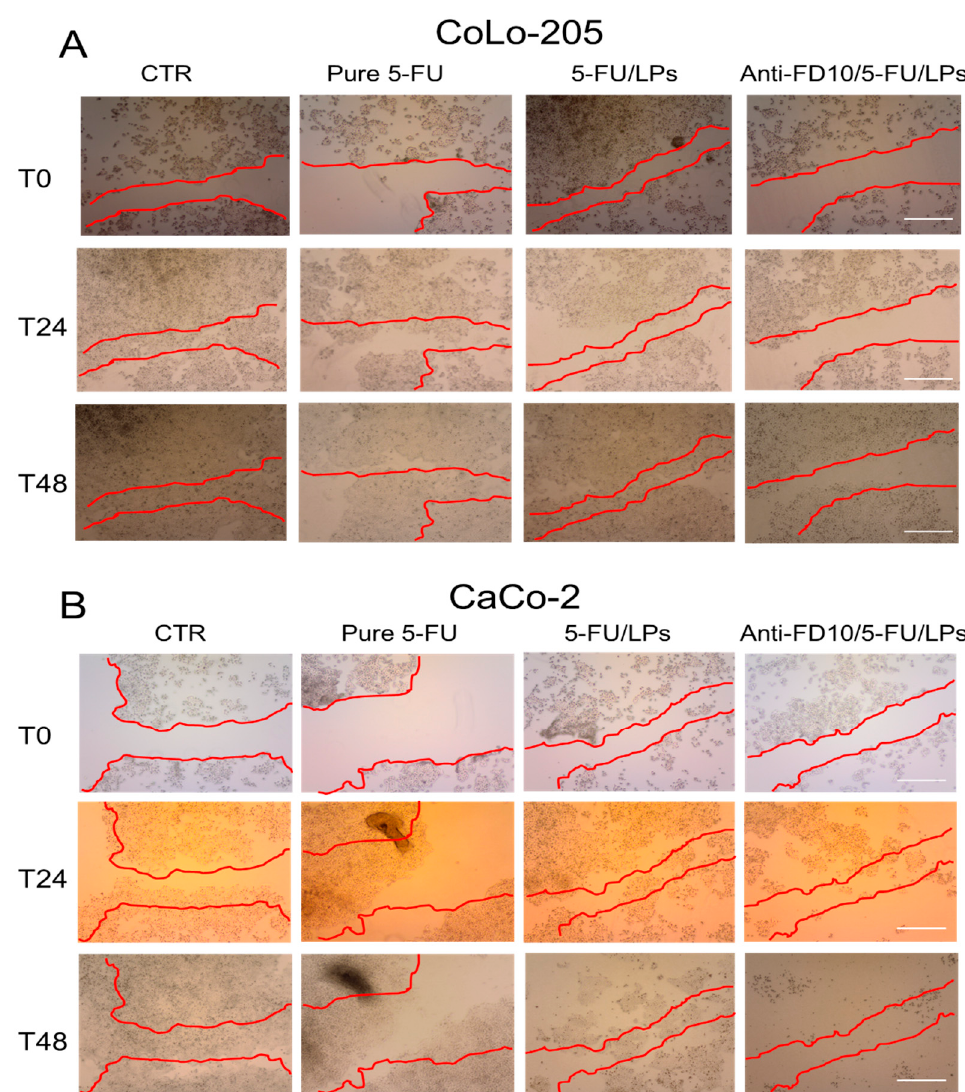
Figure 6. Qualitative analysis of collective CoLo-205 ( A ) and CaCo-2 ( B ) cell migration by in vitro scratch assay. Representative photomicrographs of scratch-wound closure of cells treated with free 5-FU, 5-FU/LPs or anti-FZD10/5-FU/LPs at different time points (0, 24 and 48 h). 5-FU concentration: 2 µM. CTR: untreated cells. Red lines represent the edges of the scratched areas. Scale bar: 200 µm.